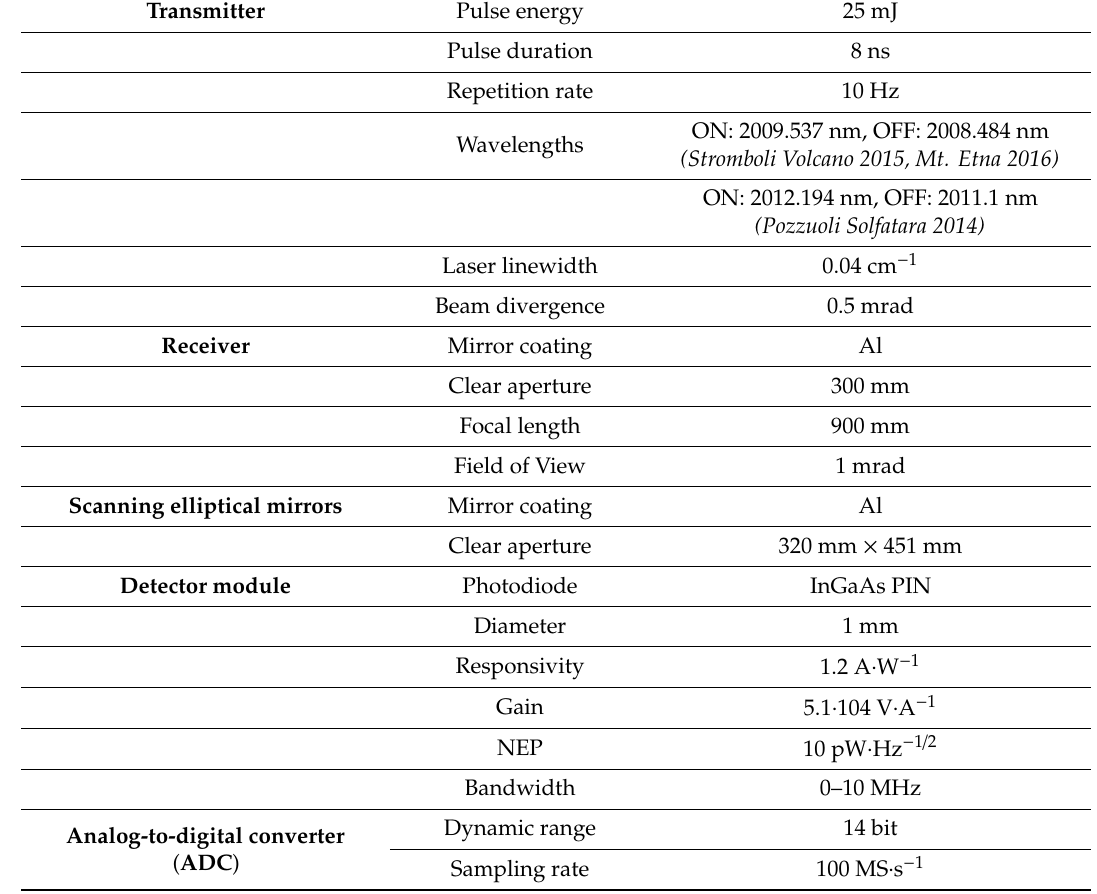
Table 1. Main specifications of the BILLI system during the BRIDGE field